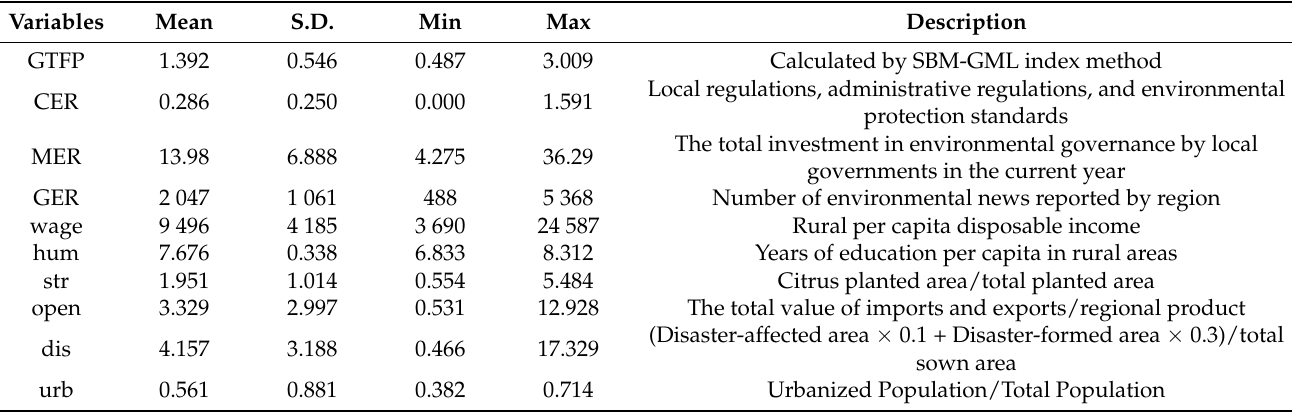
Table 3. Variable definition and descriptive statistics.